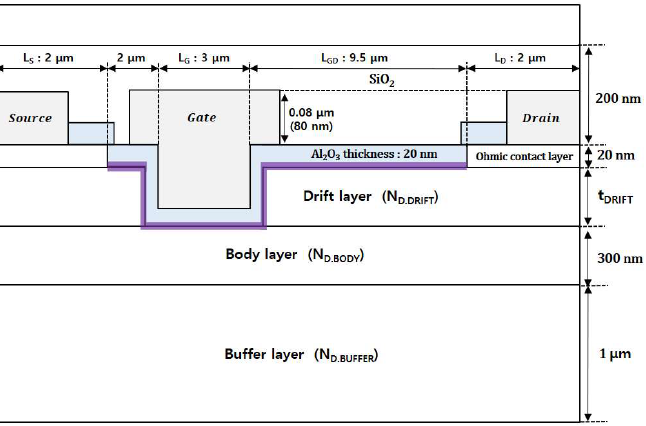
Figure 1. Cross-sectional schematic of recessed β-Ga 2 O 3 MOSFET with a dual epitaxial structure.